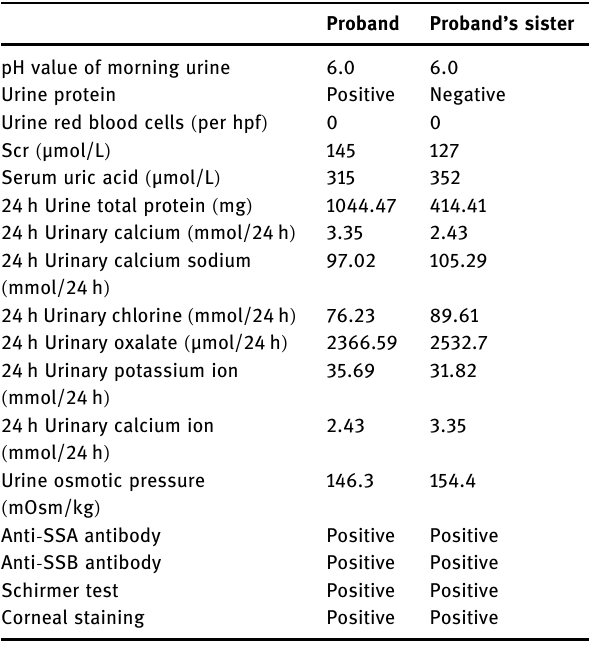
Table 1: The laboratory testing results of proband and her sister Proband Proband ’ s